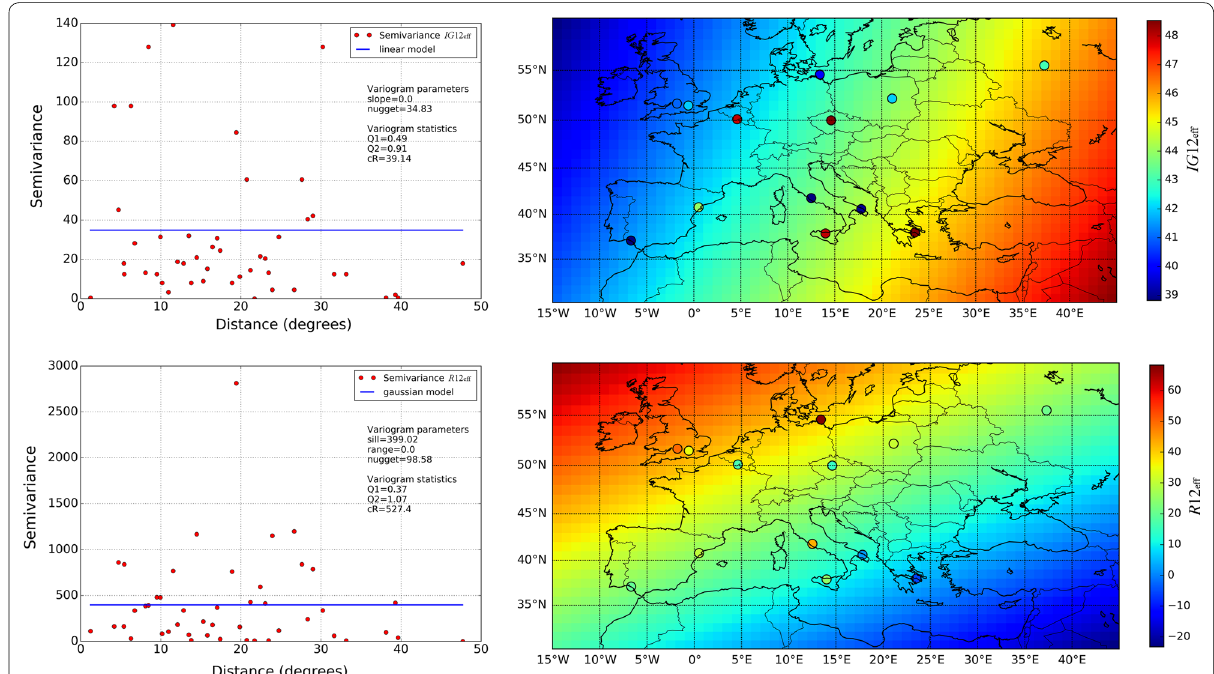
Fig. 3 Examples of discarded effective index variograms and maps. Examples of discarded variogram models (linear (top left), Gaussian (bottom left)), with corresponding maps of IG 12eff (top right) and R 12eff (bottom right), on March 20, 2015, at 16:00